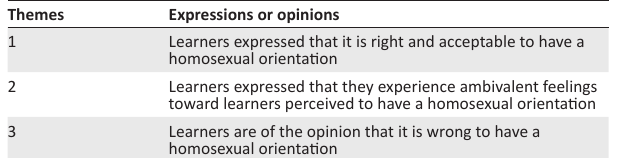
TABLE 2: Results of research: Themes.